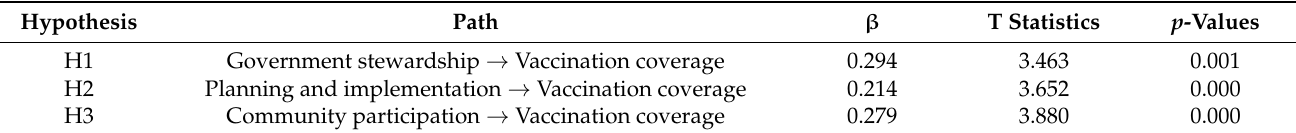
Table 7. Hypothesis